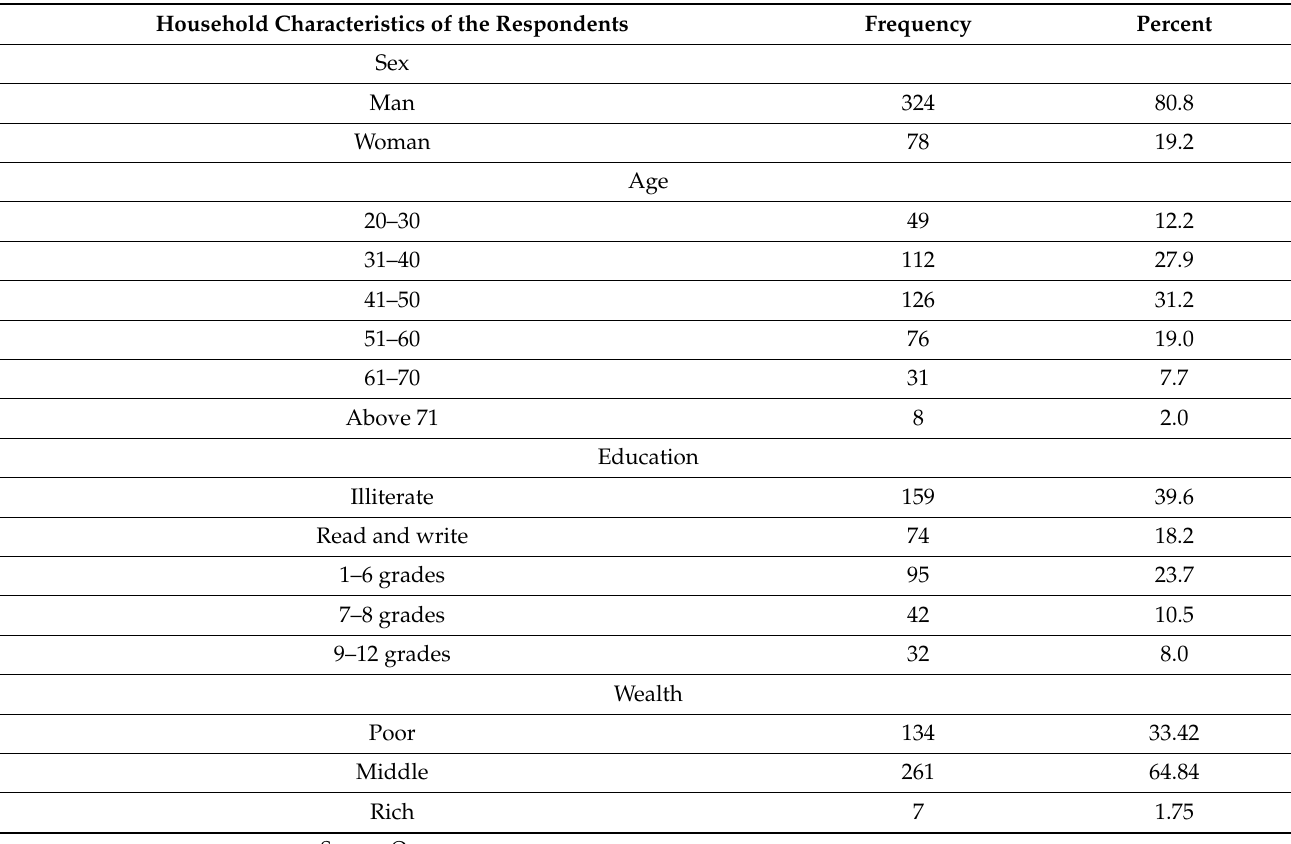
Table 3. Demographic and socio-economic characteristics of the respondents.